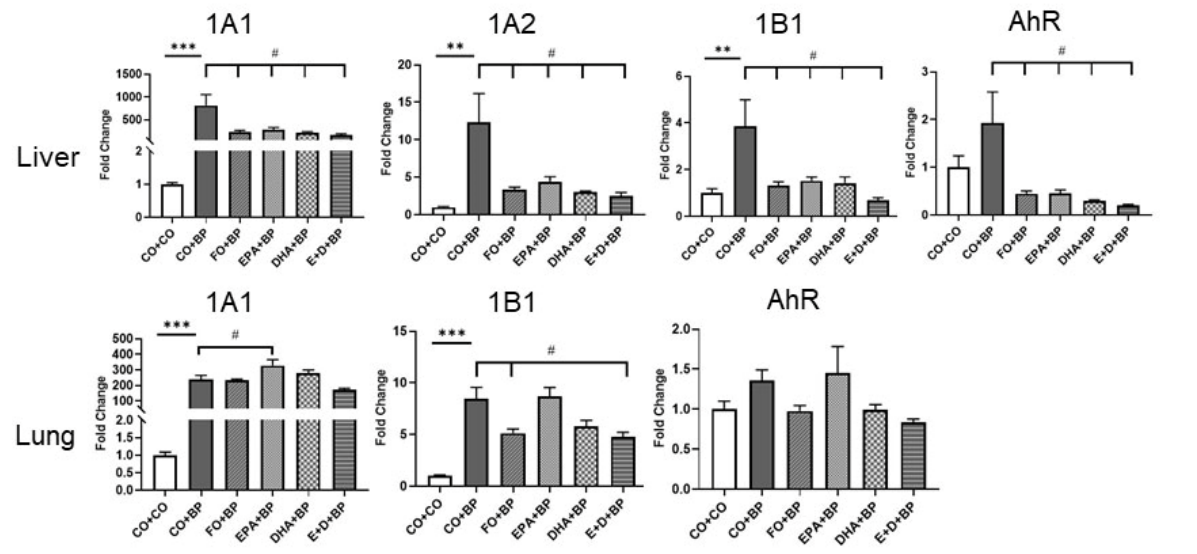
Figure 6. Effects of BP and omega-3 fatty acids on hepatic and pulmonary CYP1, and AhR gene expressions. Real time RT-PCR measurement of Cyp1a1 , 1a2 , 1b1 , and Ahr mRNA expression in liver and lung of A/J mice as written in Materials and Methods. Data are presented as mean ± SEM values by ANOVA analysis ( n = 5). Significant differences between CO + CO and CO + BP groups are denoted by **, p < 0.01, and ***, p < 0.001. Significant differences between CO + BP and omega-3 fatty acids + BP are demoted by #, p < 0.05.